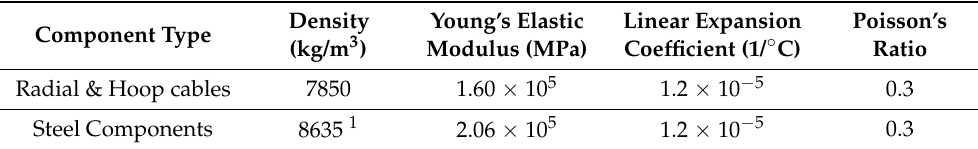
Table 2. Component material properties.